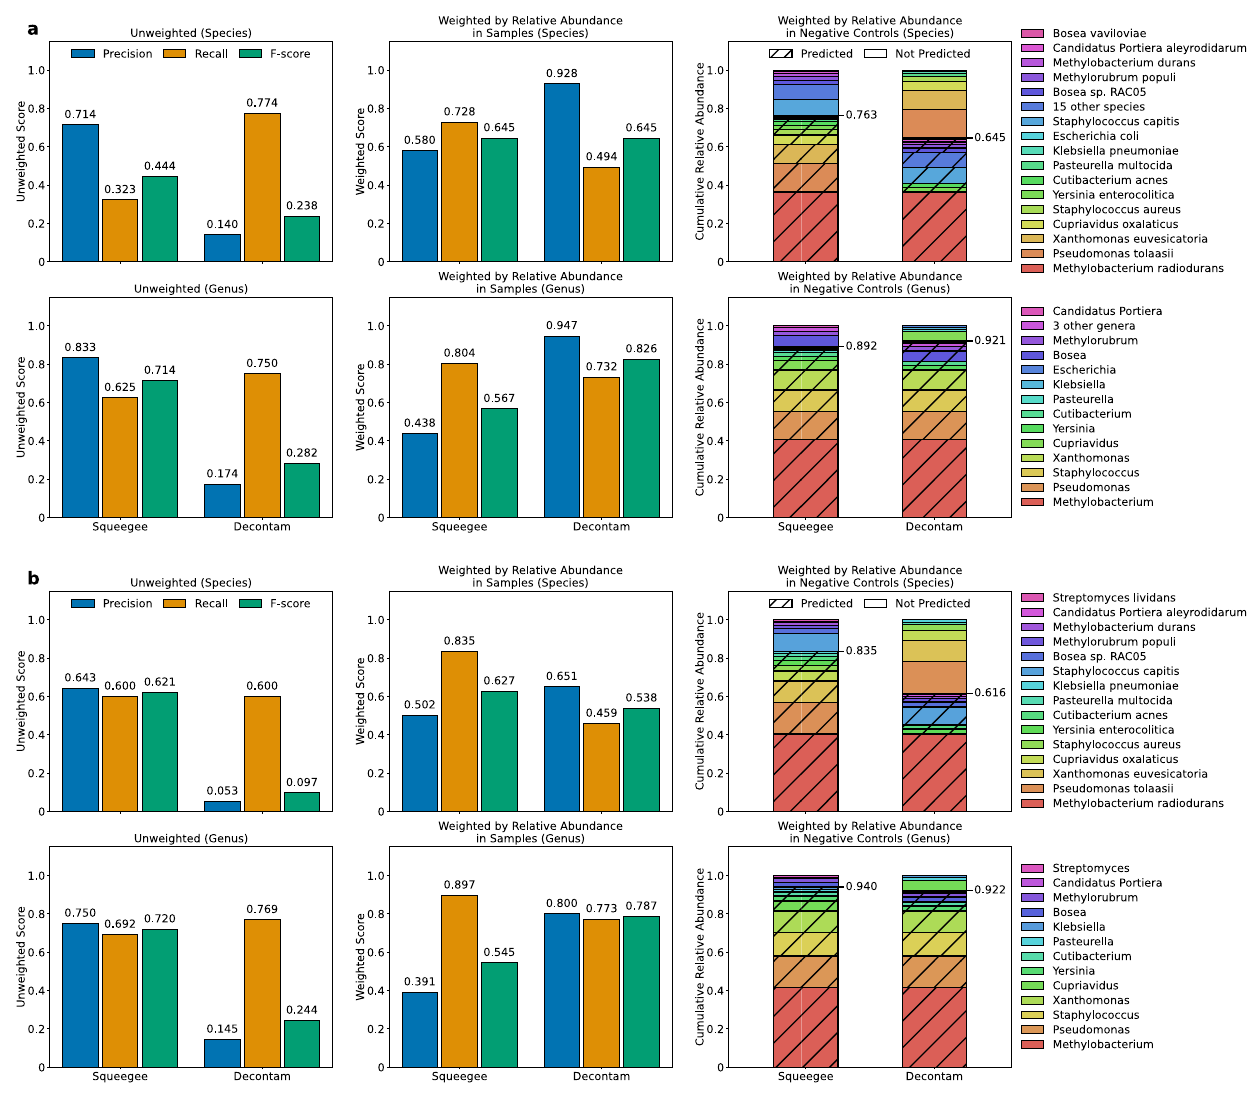
Fig. 2 | Benchmarking Squeegee with Decontam on the maternal/infant data- set. Squeegee(de novo)and Decontam(withnegativecontrol)accuracyatspecies and genus ranks are evaluated with ( a ) the permissive ground truth and ( b ) the more strict ground truth. The fi gures show the precision, recall, and F -score cal- culated at species and genus rank for both methods. The unweighted precision is calculatedastheratiobetweenthenumberofpredictedcontaminanttaxafoundin the ground truth and the total number of predicted contaminant taxa. The unweighted recall is calculated as the ratio between the number of predicted contaminant taxa found in the ground truth and the total number of taxa in the